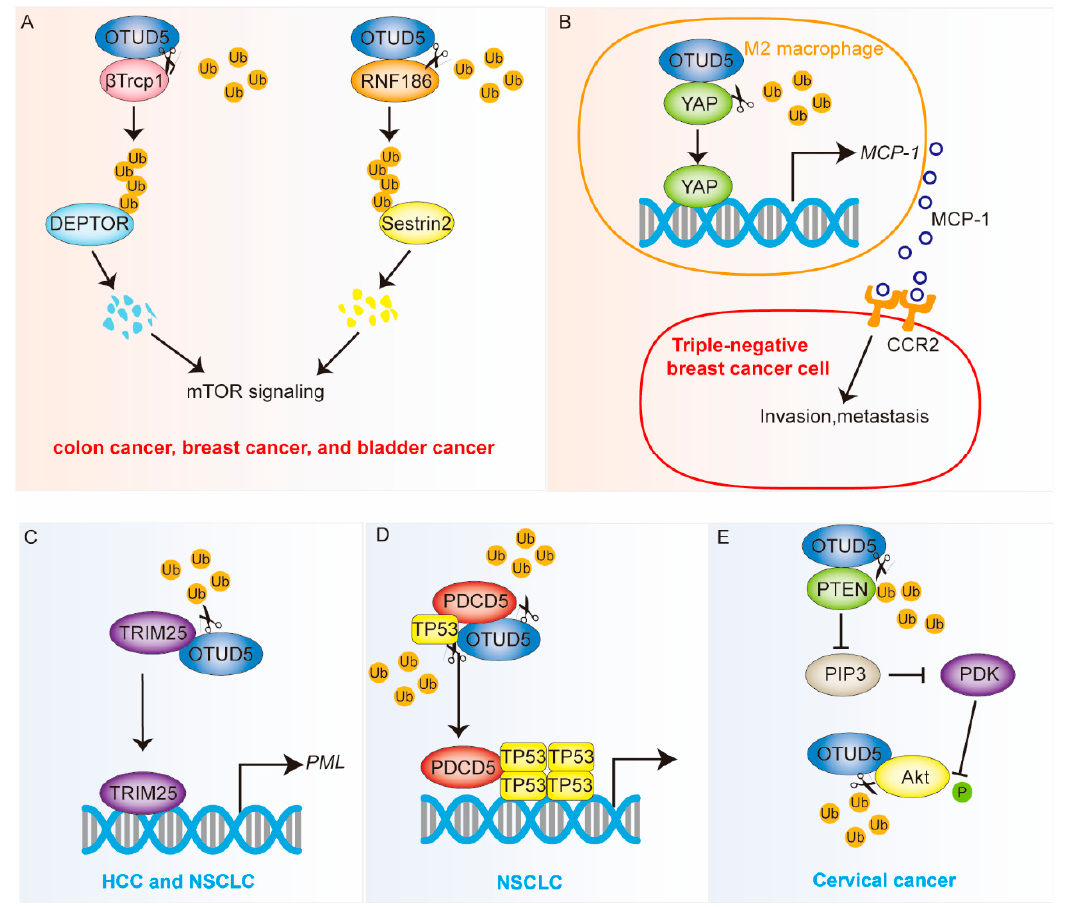
Figure 3. OTUD5 is involved in the development of cancer (see also Table 1). OTUD5 plays dual roles in tumor progression. OTUD5 is an oncogene in colon cancer, breast cancer and bladder cancer but a tumor suppressor in HCC, NSCLC and cervical cancer. OTUD5 affects multiple signaling pathways, including the mTOR, Hippo and Akt pathway. OTUD5 stabilizes key proteins, such as β Trcp1, Sestrin2, YAP, TP53, PDCD5 and Akt. OTUD5 regulates the transcriptional activity of TRIM25. ( A , B ) The orange background represents the cancer-promoting function. ( C – E ) The blue background represents the cancer-suppressing function. Ub: ubiquitin.